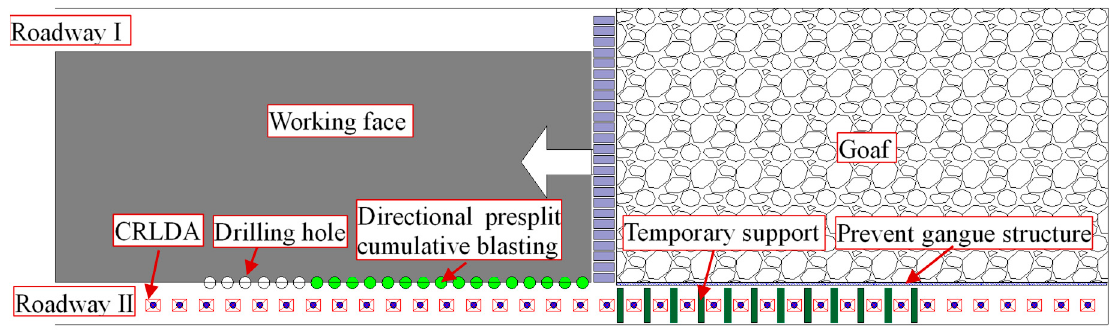
Figure 3. Technological process of GERRC .